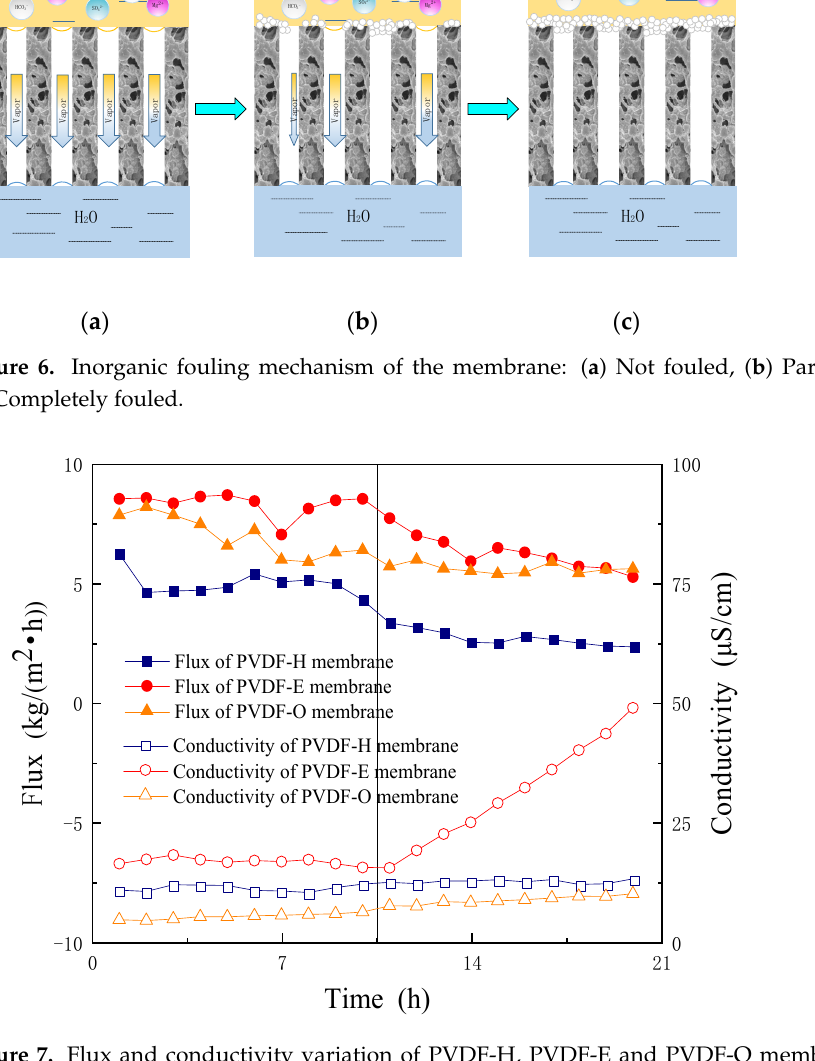
Figure 8. The state of droplets on the plane of the Young model, Wenzel model and Cassie-Baxter model. After treating high salinity mine water with the PVDF-H membrane for 20 h, no ob- vious membrane wetting phenomenon was found. Inorganic scaling did not cause serious damage to the membrane surface structure, the COD of the feed liquid was low, and there were almost no low surface energy substances that could wet the membrane in the water. Low surface tension organics such as SDS or humic acid may be introduced in the mining process, which increases the risk of membrane wetting [21]. As shown in Figure 9a, after treating high salinity mine water containing SDS, the surface of the PVDF-H membrane was covered with a layer of white granular crystals, namely saline SDS colloidal dirt. The polar group of SDS has a negative charge. The pres- ence of counterions in the feed will shield the electrostatic repulsion between the polar groups of SDS molecules and combine with SDS under the action of electrostatic attraction to form a gel layer which aggravates the phenomenon of wetting [22,23]. The counterions in high salinity mine water are mainly Na + , Ca 2+ and Mg 2+ . The binding energy and disso- ciation energy of Ca 2+ and Mg 2+ are higher than Na + , so the membrane surface pollutants